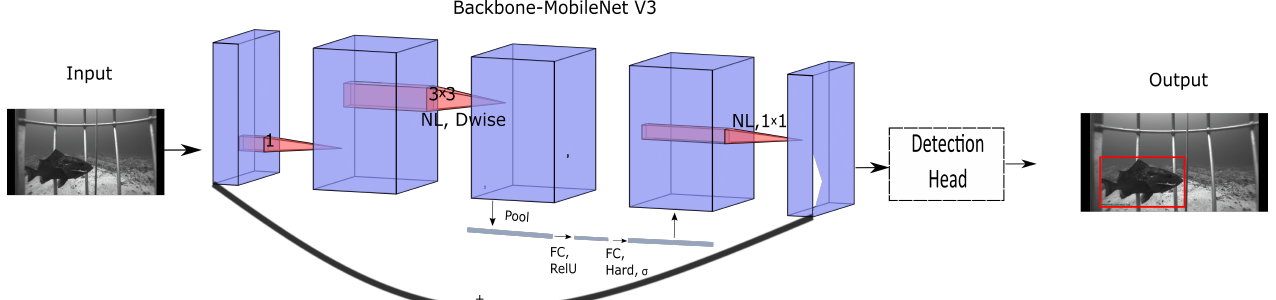
Figure 1. Proposed architecture. The architecture comprises the MobileNetv3-large [24] backbone and SSD [37] detection head. The MobileNetv3 feature extraction network is a lightweight model with good feature extraction capability. The extracted high-level features are input to the SSD detection head for classification and regression tasks. The network outputs fish species type and bounding box information for each image. The model is also trained with the VGG16 [25] backbone network.